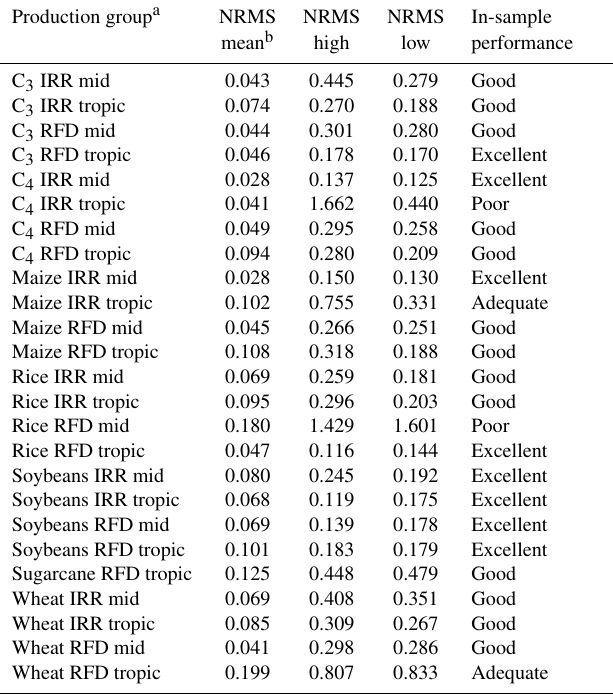
Table A2. Persephone v1.0 response function performance for all production groups, for quadratic µ CTW (Eq. A1), cubic σ CTW (Eq. A7).